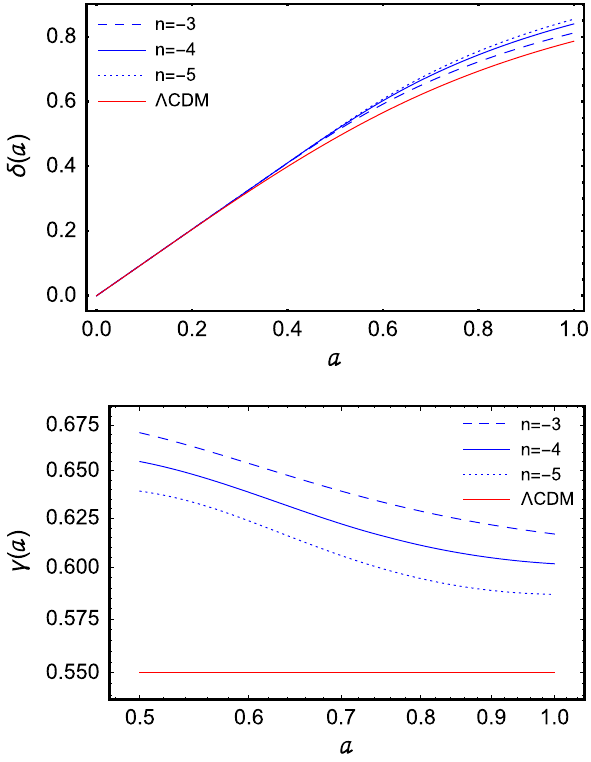
Fig. 3 In the upper graph we shown the evolution of matter density perturbation δ( a ) as a function of scale factor and for several different values of the parameter n , at k = 0 . 1 h Mpc − 1 . In lower graph it is depicted the corresponding behaviour of the growth index γ( a ) . We find a deviation with respect to the standard value γ = 0 . 55 for the Λ CDM, being that our γ( a ) assumes values larger than it, and therefore implying a smaller growth